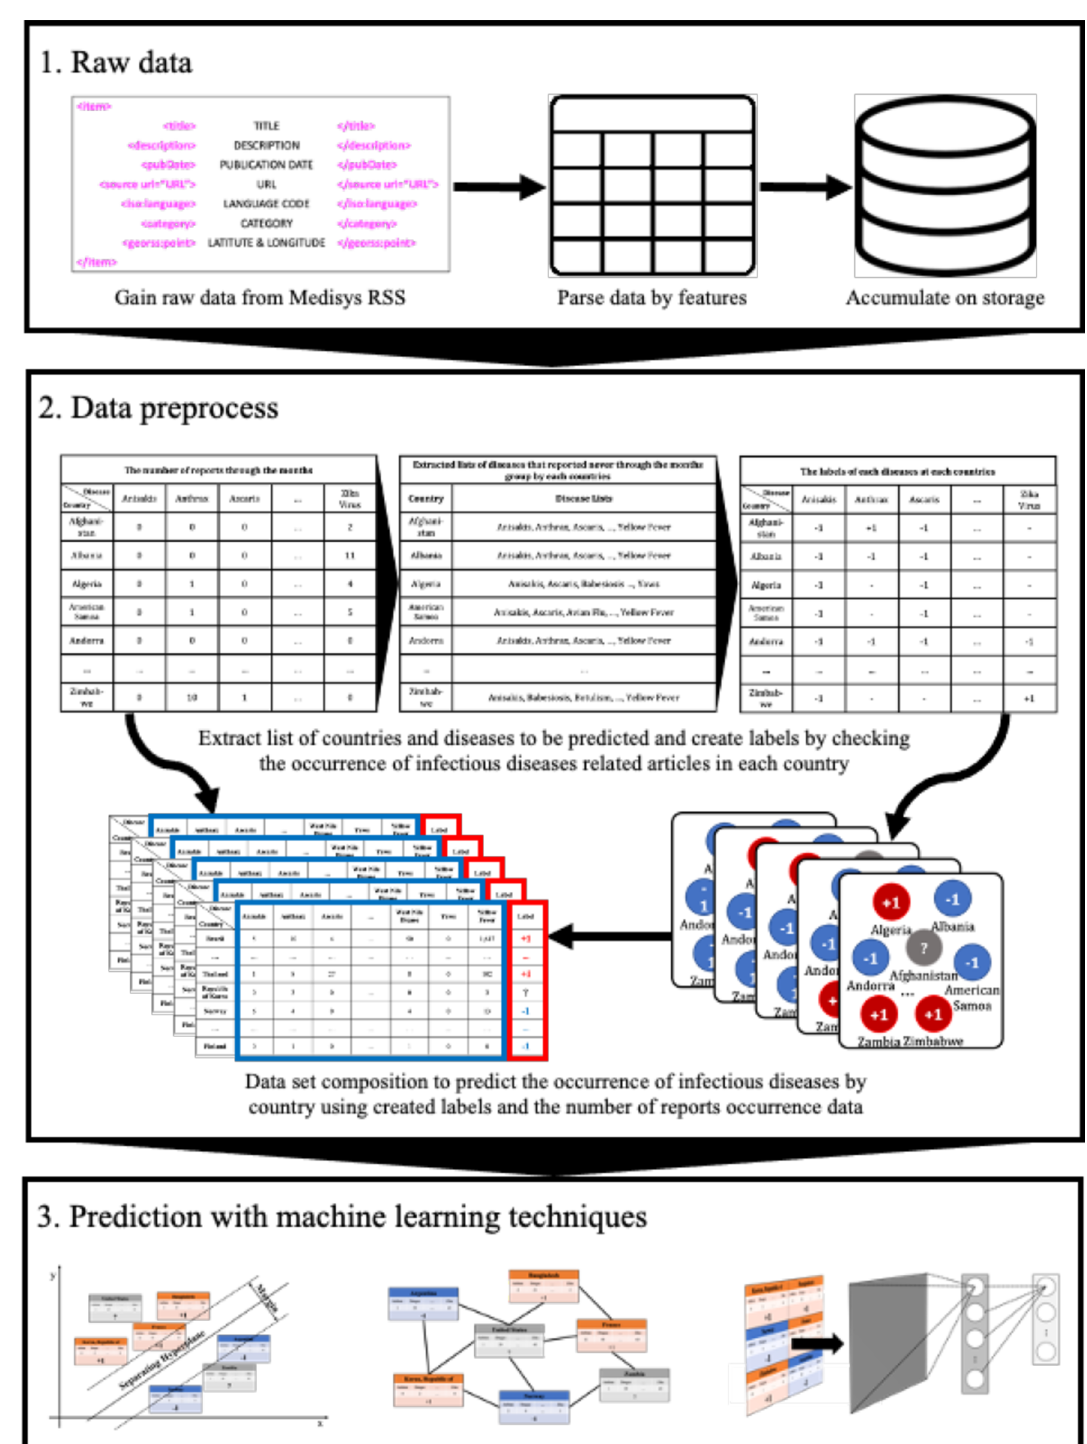
Figure 7. The order of progress from data preprocessing to